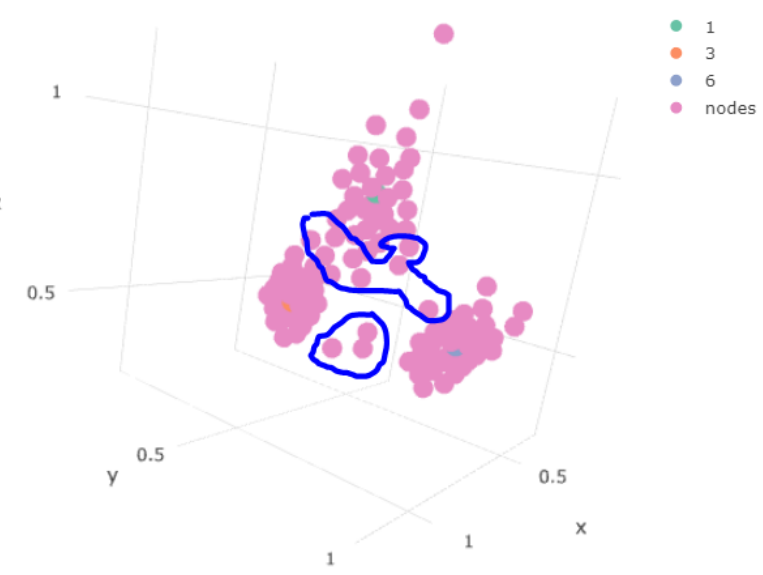
Figure 13. Status of the weights associated with the map generated for the first stratum.